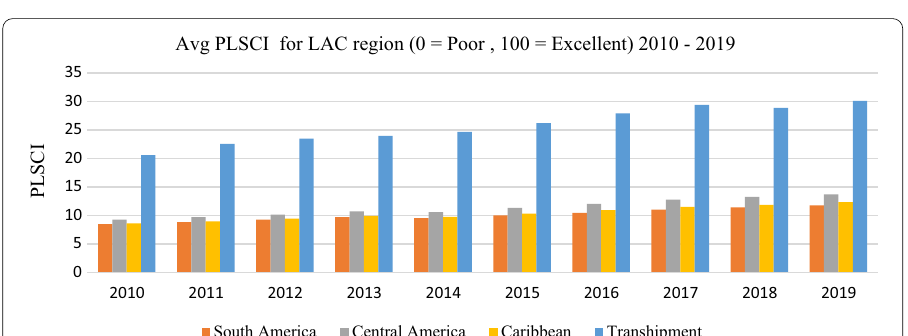
Fig. 5 Port Liner Shipping Connectivity Index (PLCI). Index (Maximum Q1 2006